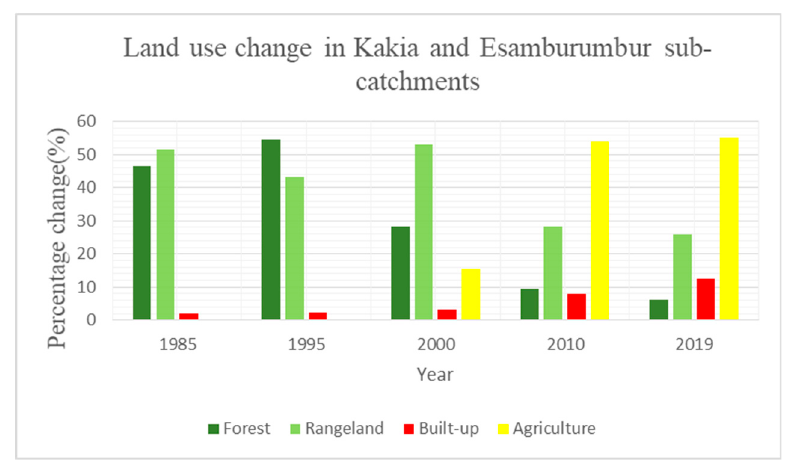
Figure 6. Land use land cover change in the study area.